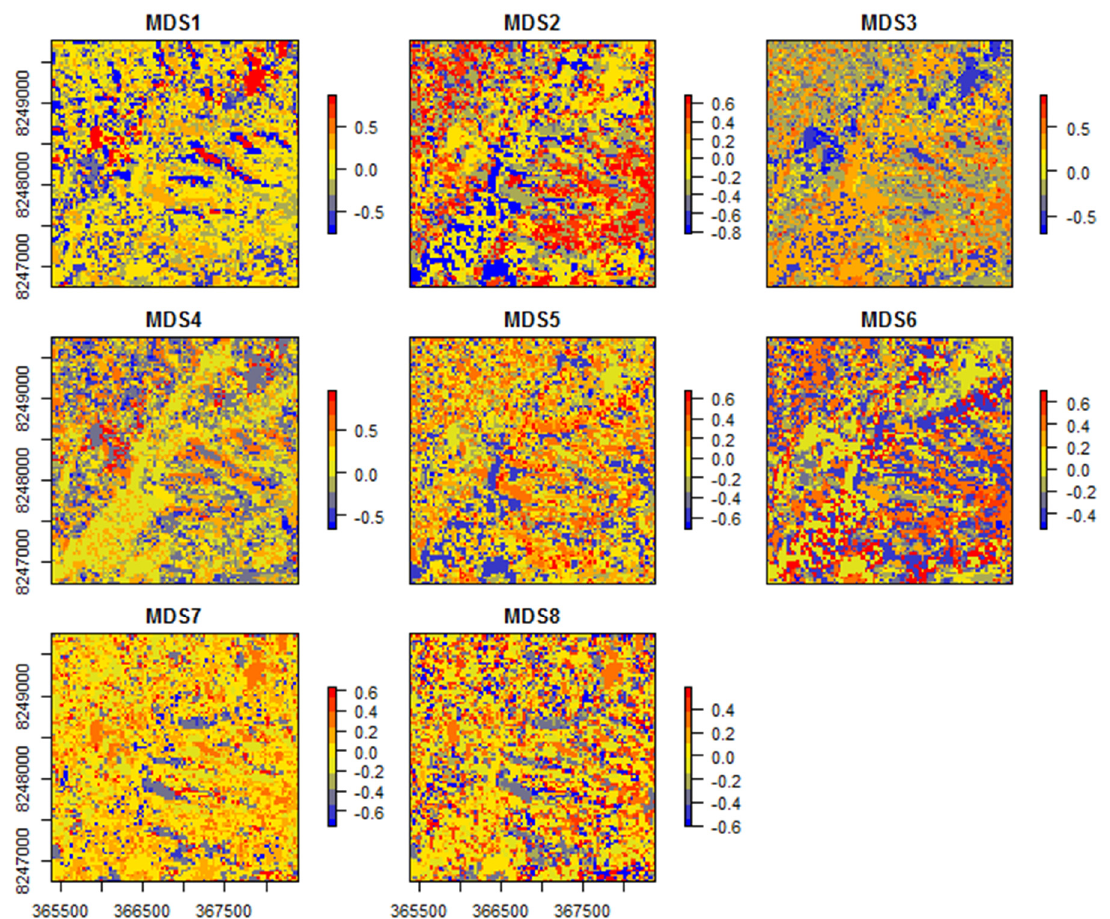
Figure 6. Plots of the eight non-metric multidimensional scaling (NMDS) axes representing the tree community transitions in the study area, according to the sparse generalized dissimilarity modelling (SGDM) model predictions.